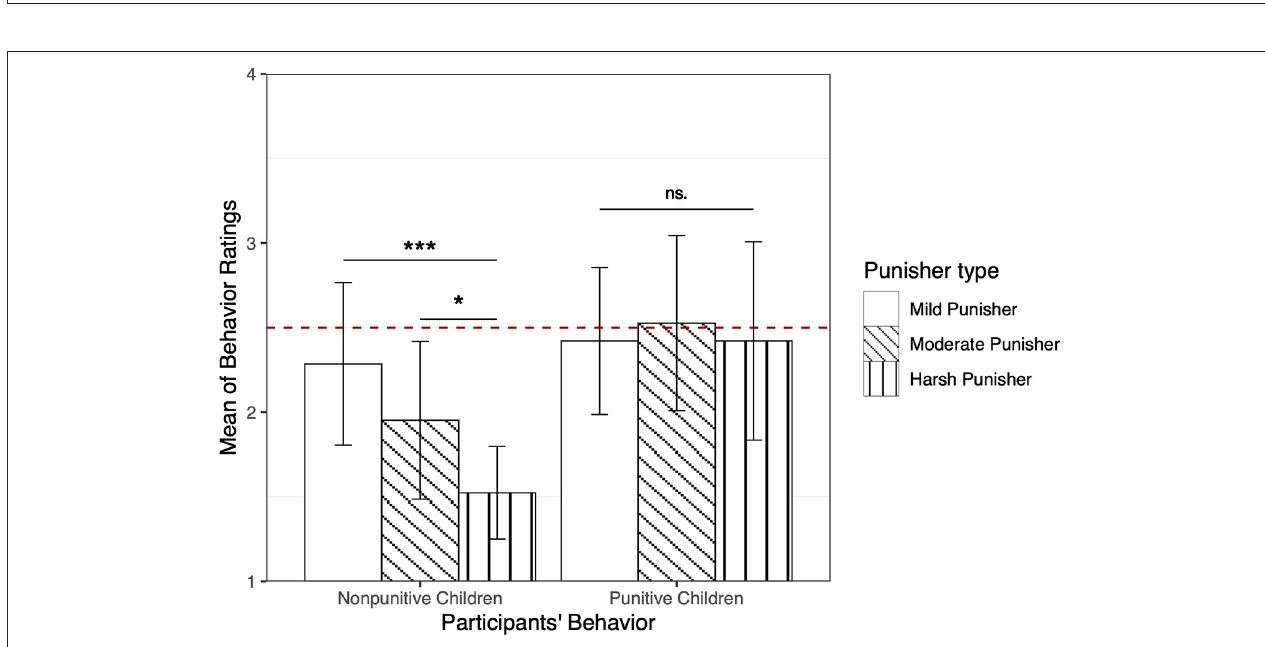
FIGURE 4 | The behavior ratings of 3 punishers in two types of children whose behavior was non-punitive (i.e., communication or restoration) or punitive. For non-punitive children, their behavior ratings of the mild punisher and the moderate punisher were significantly higher than behavior ratings of the harsh punisher. For punitive children, their behavior ratings of three punishers were not significantly different. Values are expressed as the means and error bars as the 95% CI. *** p < 0.001, * p < 0.05. ns. = not significant ( p > 0.05).